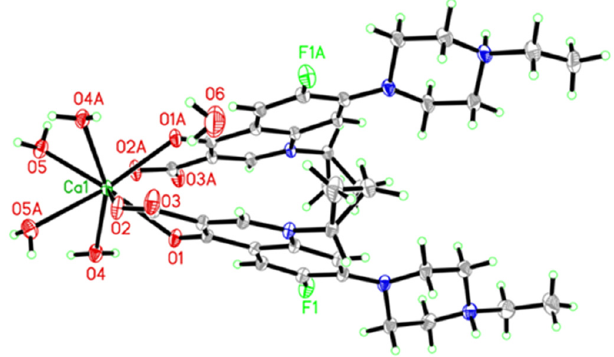
Figure 1. The ORTEP drawing for the crystal structure of EFX-Ca. Table 1. Crystallographic and refinement parameters for